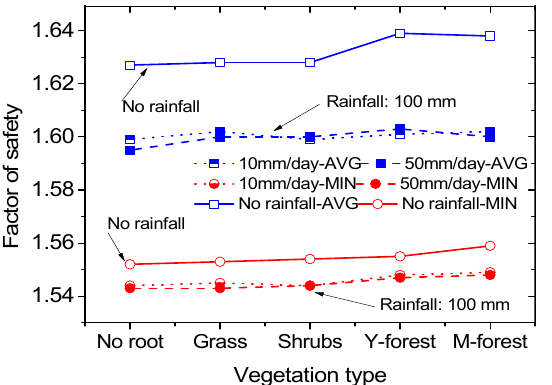
Figure 13. Comparison of the factor of safety for the cases with accumulative rainfall amount of 100 mm and no rainfall using both average and minimum soil strength parameters. 100 mm and no rainfall using both average and minimum soil strength